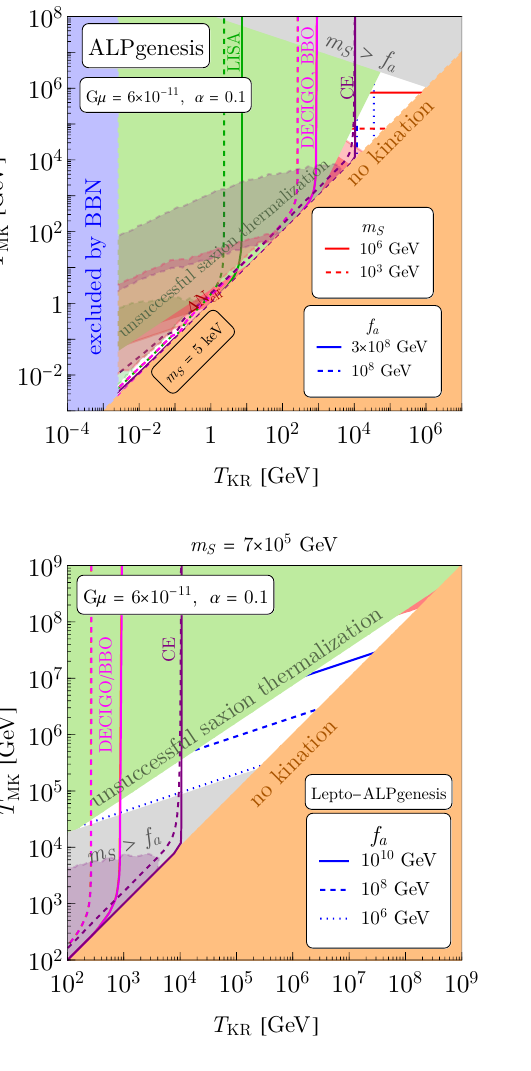
Figure 15 . Detector reach of the kination cosmic string gravitational wave spectrum for a range of T KR and T MK consistent with minimal ALPgenesis (top) and lepto-ALPgenesis (bottom). The top-right panel zooms in on the bottom-left part of the top-left panel. Gµ and α are fixed at 6 × 10 − 11 and 0 . 1 , respectively, to fit the NANOGrav data [41]. For a given ( T KR , T MK ) , a detection is registered when the difference in amplitudes, Ω GW − Ω GW , 0 is greater than 10% (solid) or 100% (dashed) of the standard cosmological amplitude, Ω GW , 0 , within the sensitivity curve the detector. In the transparent shared regions, the peak of the spectrum originated from axion kination can be